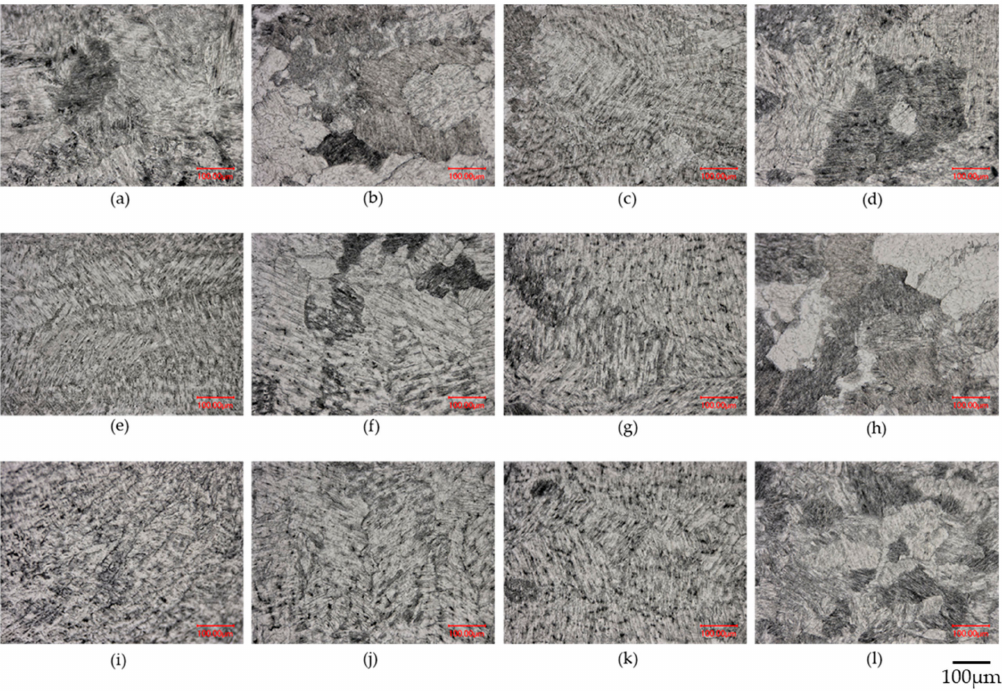
Figure 6. Optical micrographs of Ti–Al–X ternary alloy in as-cast state; ( a ) 1.8Nb; ( b ) 4.0V; ( c ) 0.6Mo; ( d ) 0.6W; ( e ) 0.6Fe; ( f ) 2.4Cr; ( g ) 2.4Mn; ( h ) 0.6Ni; ( i ) 0.4Si; ( j ) 0.07C; ( k ) 0.07N; ( l ) 0.10B.